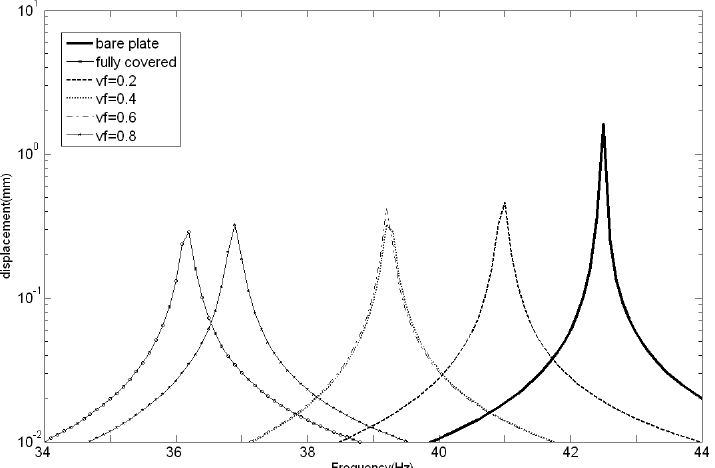
Fig. 16. The third natural frequency.